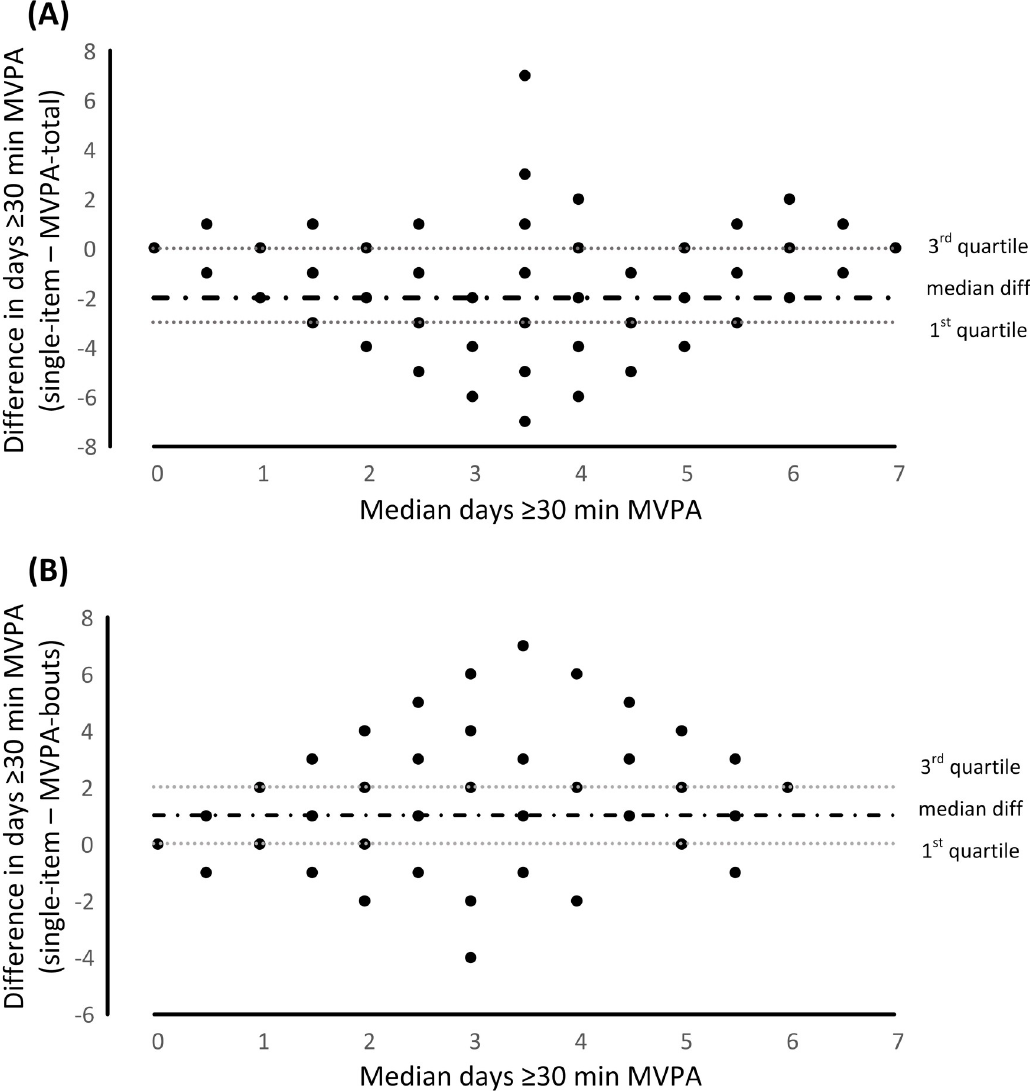
Fig 1. Difference in days � 30 minutes of moderate-to-vigorous intensity physical activity (MVPA) between the single item measure (SIM) and accelerometry: (A) total MVPA (MVPA-total) and (B) MVPA occurring in bouts (MVPA-bouts). Median difference and inter-quartile range for the ordinal distributions are presented as dotted horizontal lines against the median of the two measures (single-item and accelerometer). for both weeks for 90 participants (70% valid responses at baseline and follow-up; 71 females, 18 males, 1 other; age: 47 ± 11 years, stature: 167 ± 8 cm, body mass: 74.2 ± 14.5 kg, body mass index: 26.7 ± 4.7 kg/m 2 ) and these data were included in analyses of change in physical activity from week one to week two.